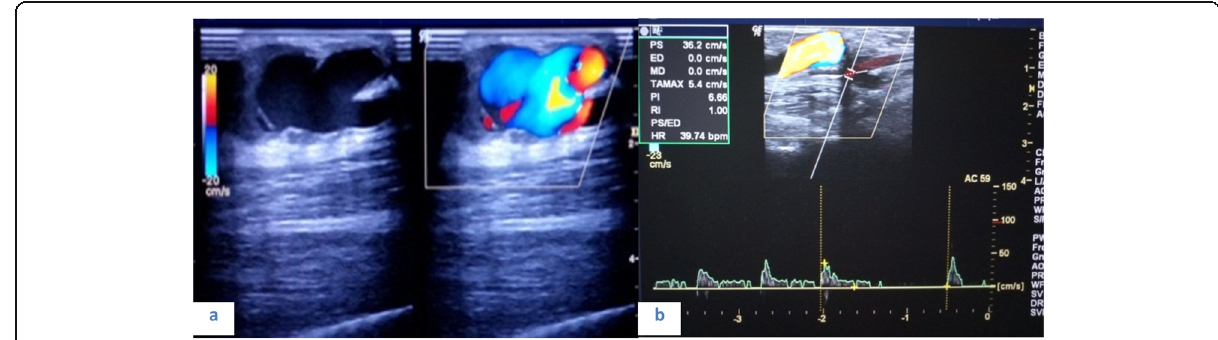
Fig. 4 Patient with B-C AVF. a CDUS shows two pulsatile swellings denoting aneurysmal dilatation of the cephalic vein. b Pulsed Doppler show juxta-anastomotic stenosis of the AVF ostia with low PSV proximal to the